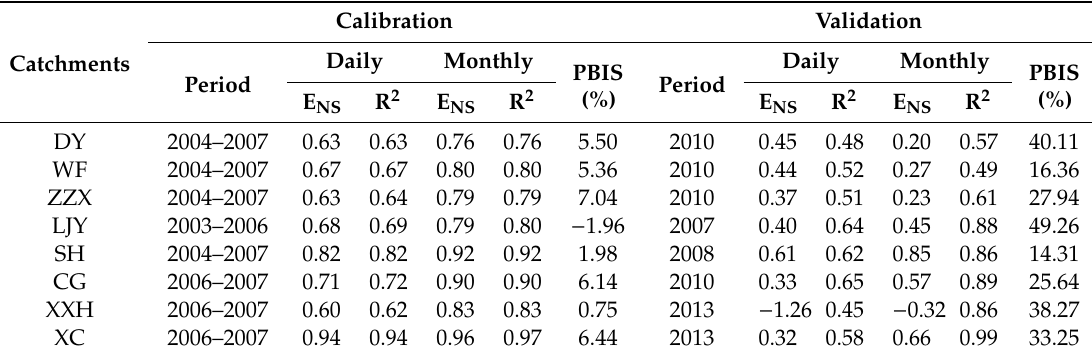
Table 3. Model performance during the calibration and validation for the study catchments. Calibration Catchments